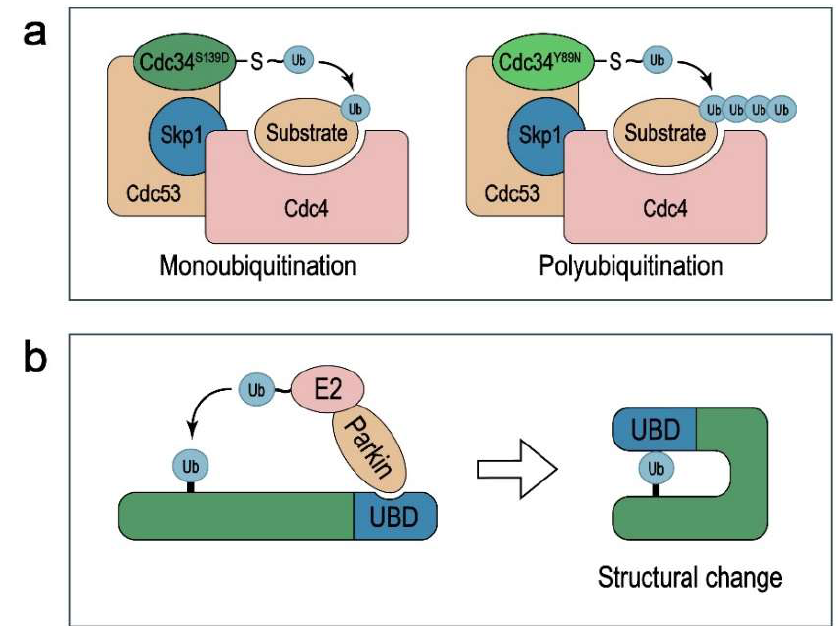
Figure 1. The models for mechanisms that dictate whether a protein is monoubiquitinated or polyubiquitinated. ( a ) The amino acids in the catalytic region of E2s and their compatibility with the residues surrounding the lysine residues in the substrate and ubiquitin serve as the determinants. For example, key residues in the catalytic core of the yeast E2–E3 complex Cdc34–SCF Cdc4 dictate the lysine preference of Cdc34 and whether this complex monoubiquitinates or polyubiquitinates its substrate. ( b ) The structural changes of the monoubiquitinated substrate restrict its further polyubiquitination. For example, the ubiquitin-binding domain (UBD) of the adaptor protein Eps15 is blocked after being monoubiquitinated by the RING-family E3 ligase Parkin, which limits ubiquitin chain